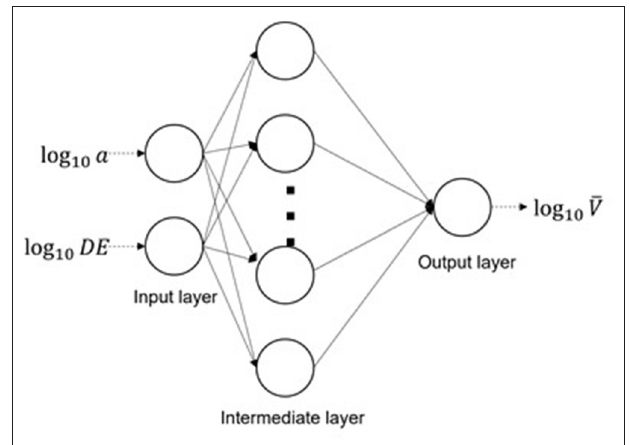
FIGURE 2 | Illustration of an artificial neural network. Each circle is a neuron, basic computation unit, in the network. Each arrow represents a computation connection from the neurons in last layer to the one in current